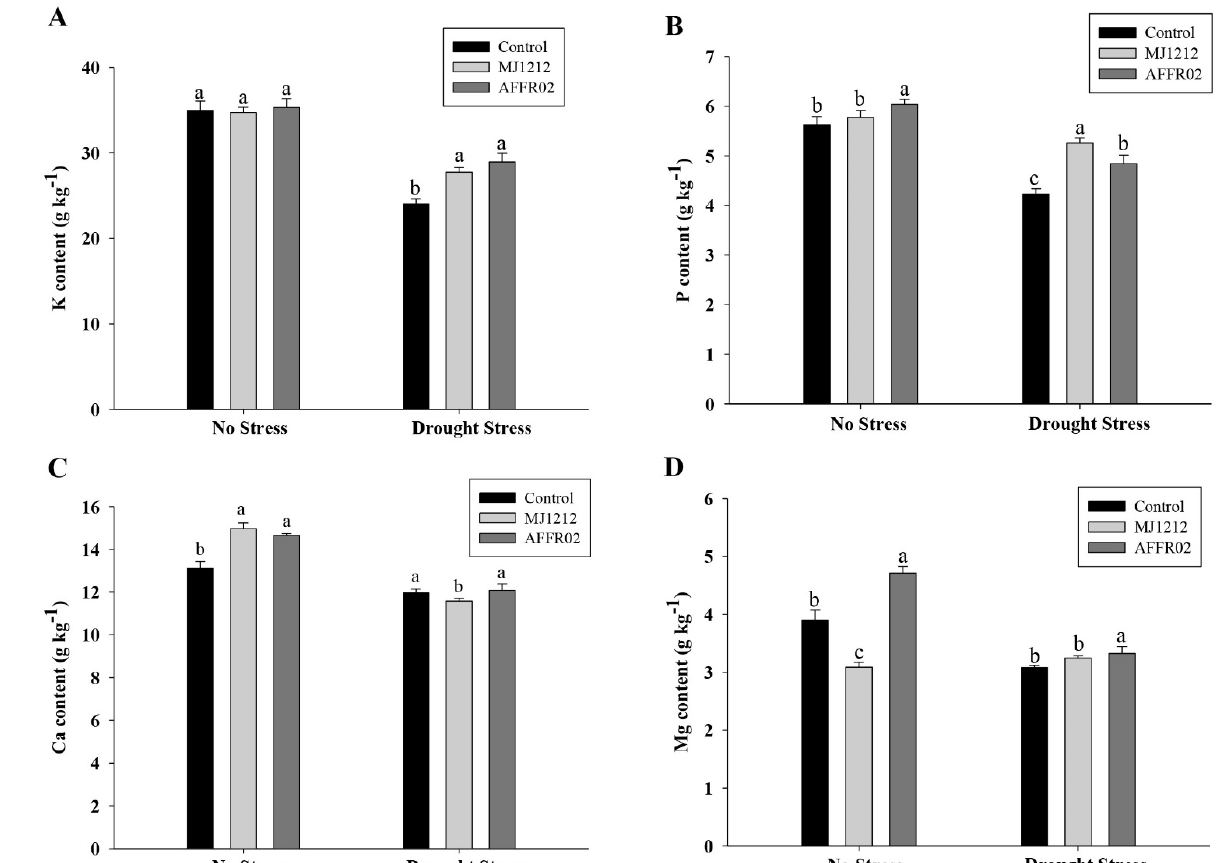
Figure 6. Effect of isolate AFFR02 and MJ1212 on ( A ) potassium content (K), ( B ) phosphorous (P), ( C ) calcium (Ca), and ( D ) magnesium content (Mg) of alfalfa plants under normal and post-drought stress. The values given are the mean of three replicates and error bars indicate the standard deviation. The bars presented with different letters are significantly different from each other by using Duncan’s multiple range test at p > 0.05.